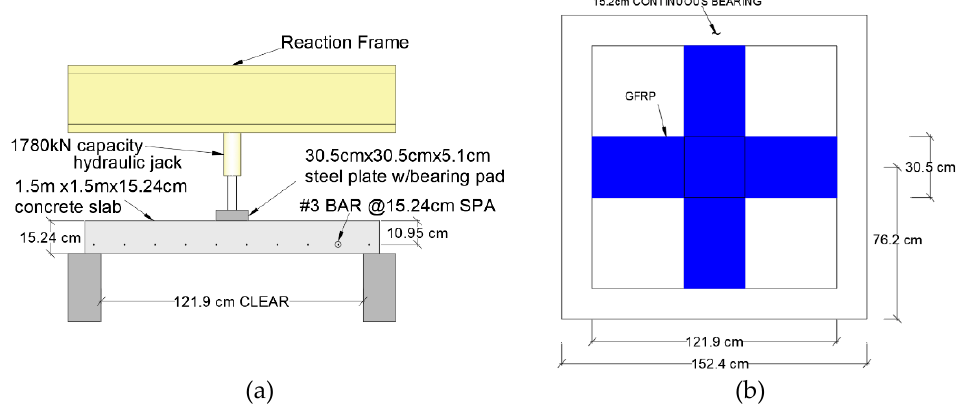
Figure 16. ( a ) Test apparatus with loading from top of the slab producing tension at the bottom, ( b ) 30.4 cm wide GFRP strips bonded to the tension face [38].